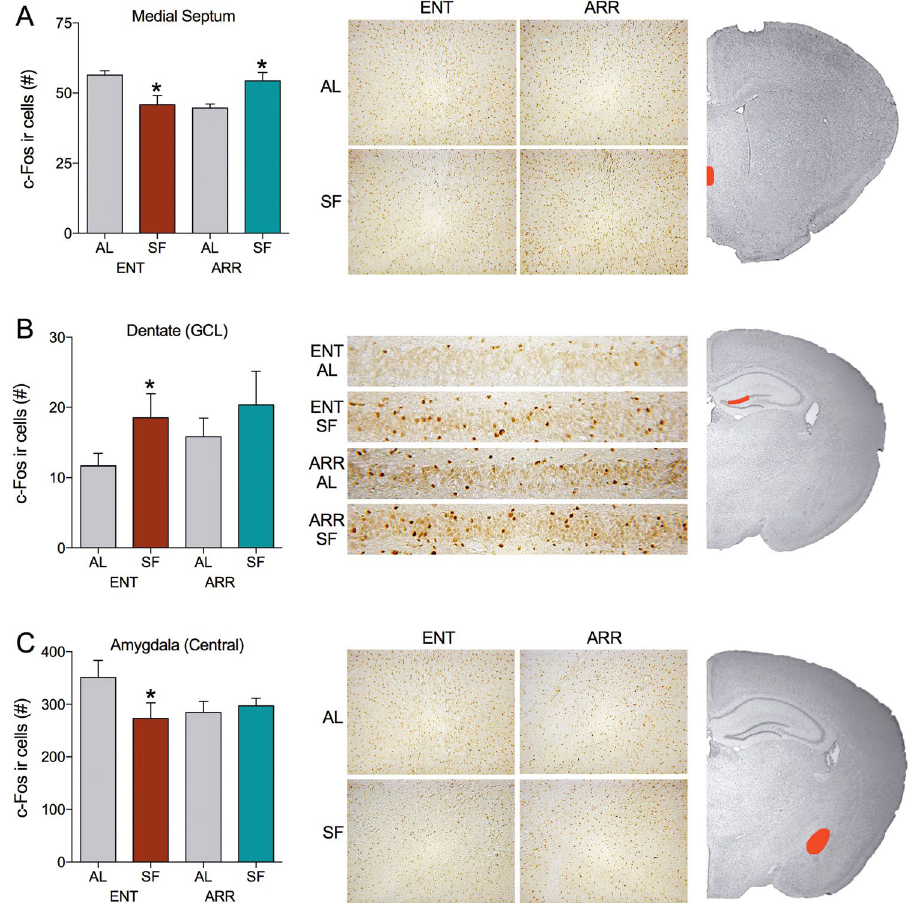
Figure 4. SF equalized c-Fos expression among ENT and ARR animals in specific non-SCN brain regions. Bar graphs show mean ( ± SE) number of c-Fos IR cells in each group for the ( A ) medial septum, ( B ) granule cell layer of the dentate gyrus, and ( C ) central nucleus of the amygdala ( * P < 0.05 compared to AL condition). The middle column of panels shows representative c-Fos labeling in brain sections from all four groups of animals. Red areas in hamster coronal sections on the right column indicate the areas in which cells were